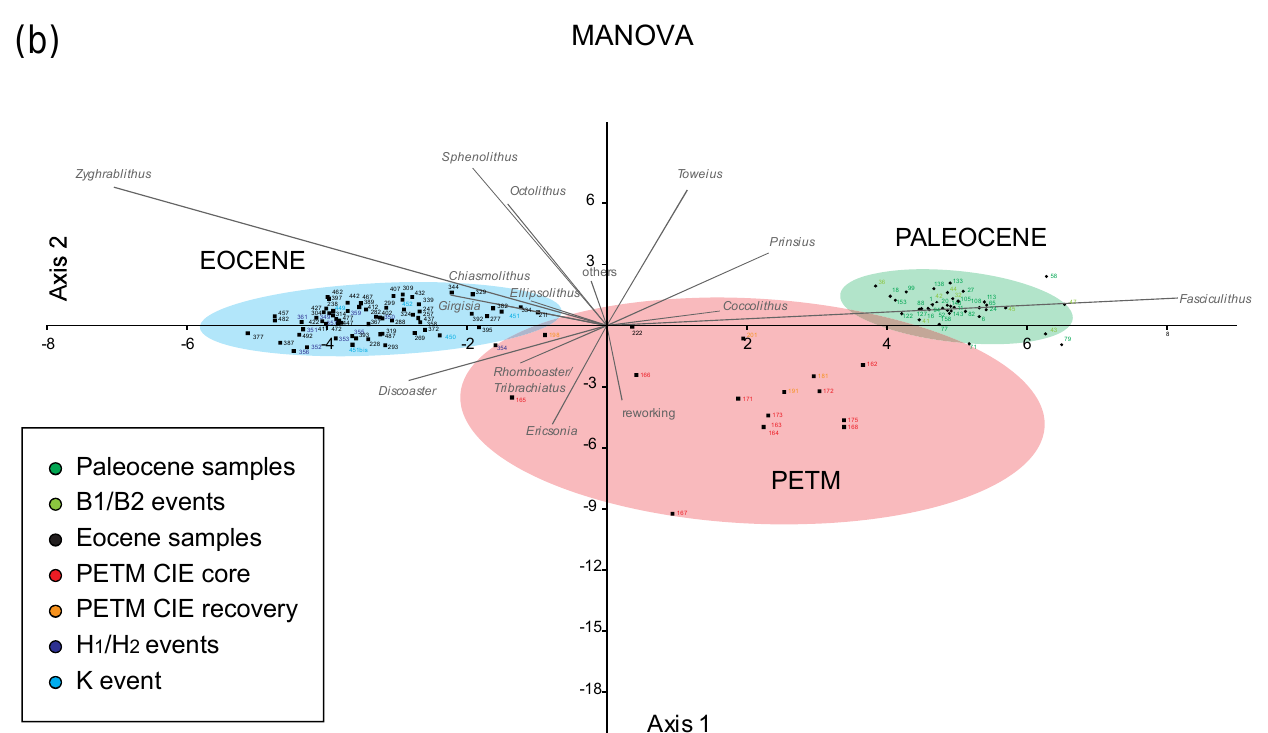
Figure 10. Statistical Analyses of calcareous nannofossil percentage data of the Cicogna section. Calcareous nannofossils are subdivided into 15 subgroups ( Chiasmolithus , Coccolithus , Ellipsolithus , Discoaster , Ericsonia , Fasciculithus , Girgisia , Octolithus , Prinsius , Sphe- nolithus , Toweius , Rhomboaster/Tribrachiatus , Zyghrablithus , reworking, others). (a) Principal component analysis (PCA) scatter plot of percentage data of calcareous nannofossil taxa of samples from the Cicogna section in terms of the first and second component. Each sample is represented by a circle and labeled. Green and blue shaded areas are the ellipses containing 95% of the data points of Paleocene group and Eocene group, respectively. (b) Multivariate analysis of variance (MANOVA). Scatter graph and biplot. Each sample is represented by a black symbol (quadrangle and diamond) and labeled. Green, red and blue shaded areas are the ellipses containing 95% of the data points of Paleocene group, PETM group and Eocene group,